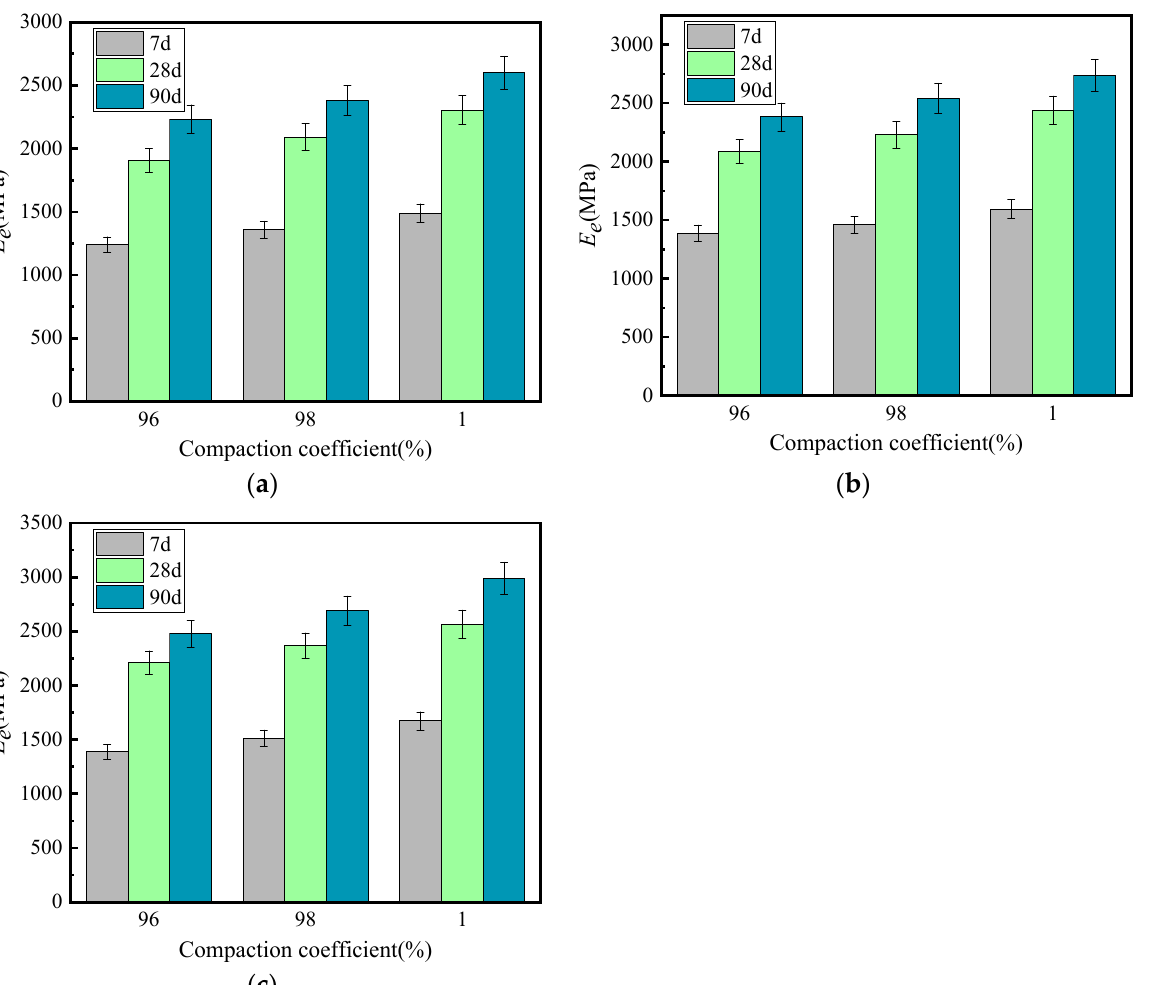
Figure 13. Growth law of resilient modulus under different compaction coefficients. ( a ) GF1, ( b ) GF2, ( c )